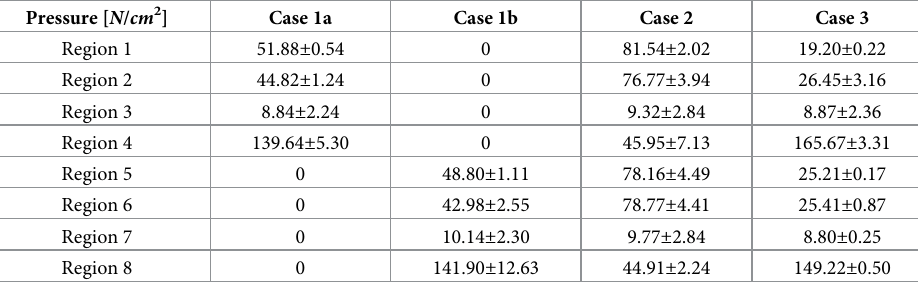
Table 4. Experimental evaluation of the upper platform under static condition.